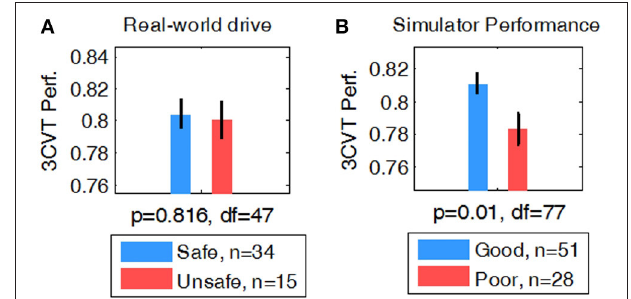
FIGURE 4 | Comparison of F-measure for (A) Safe vs. Unsafe and (B) Good vs.